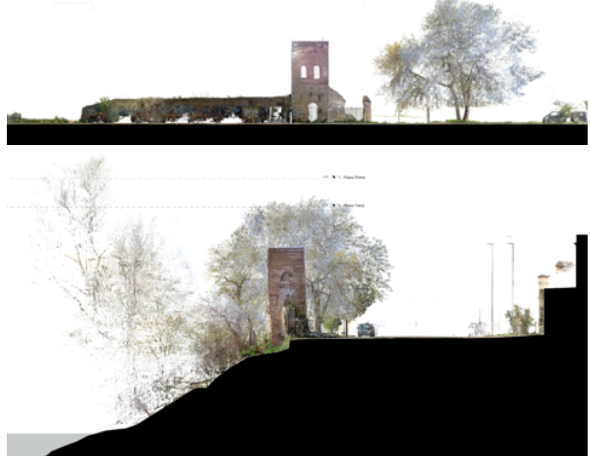
Figure 3: Longitudinal and transversal section, obtained by importing the dense cloud into Autodesk Revit